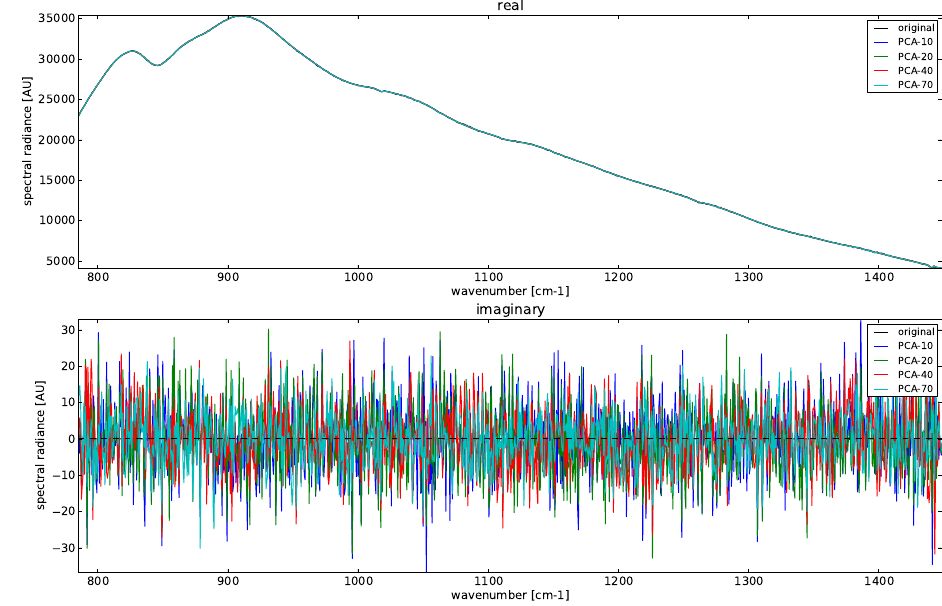
Figure 7. Reconstruction of a BB spectrum (centre pixel) from 10, 20, 40, and 70 principal components.